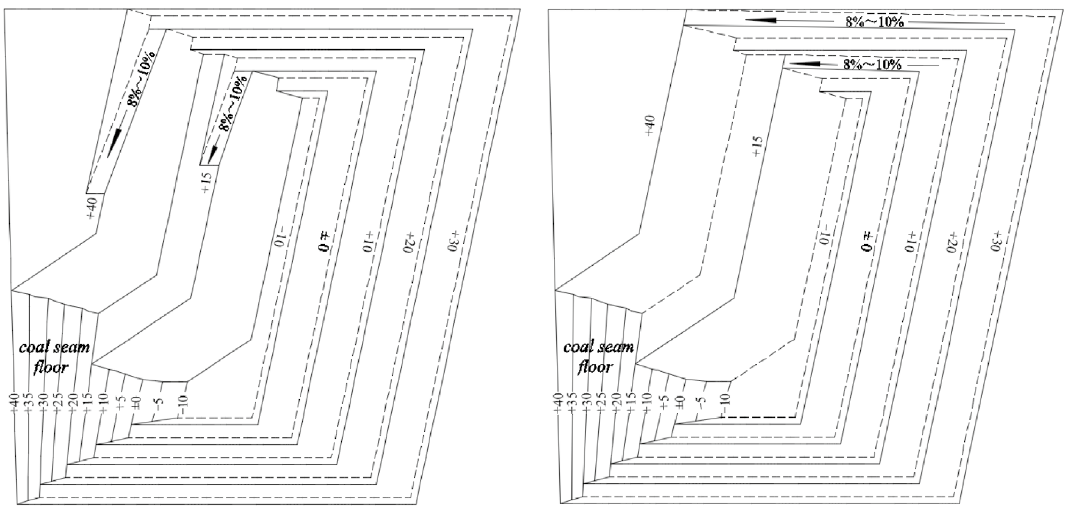
Fig. 10 Diagram of haulage system layout in anticline region